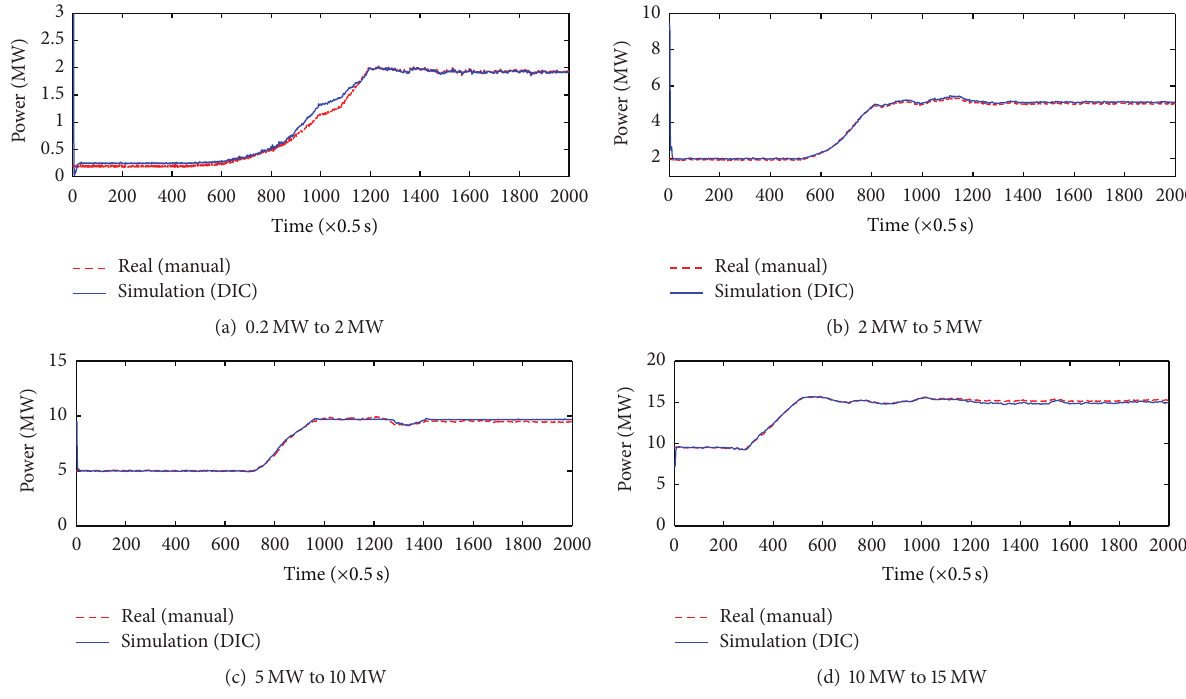
Figure 7: Response of using the DIC controller compared to manual control for the operating power at different power